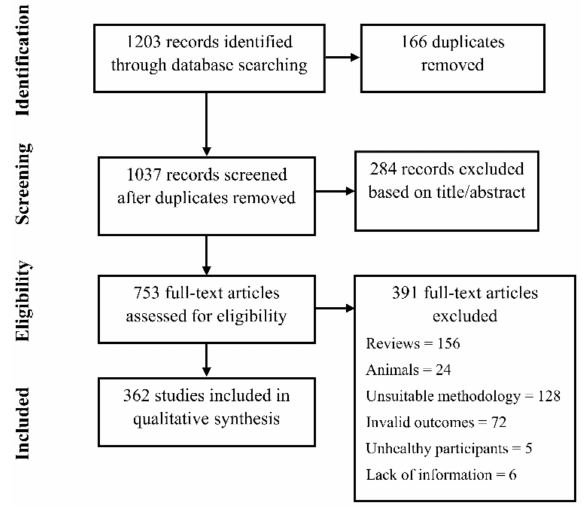
Figure 1. Selection of